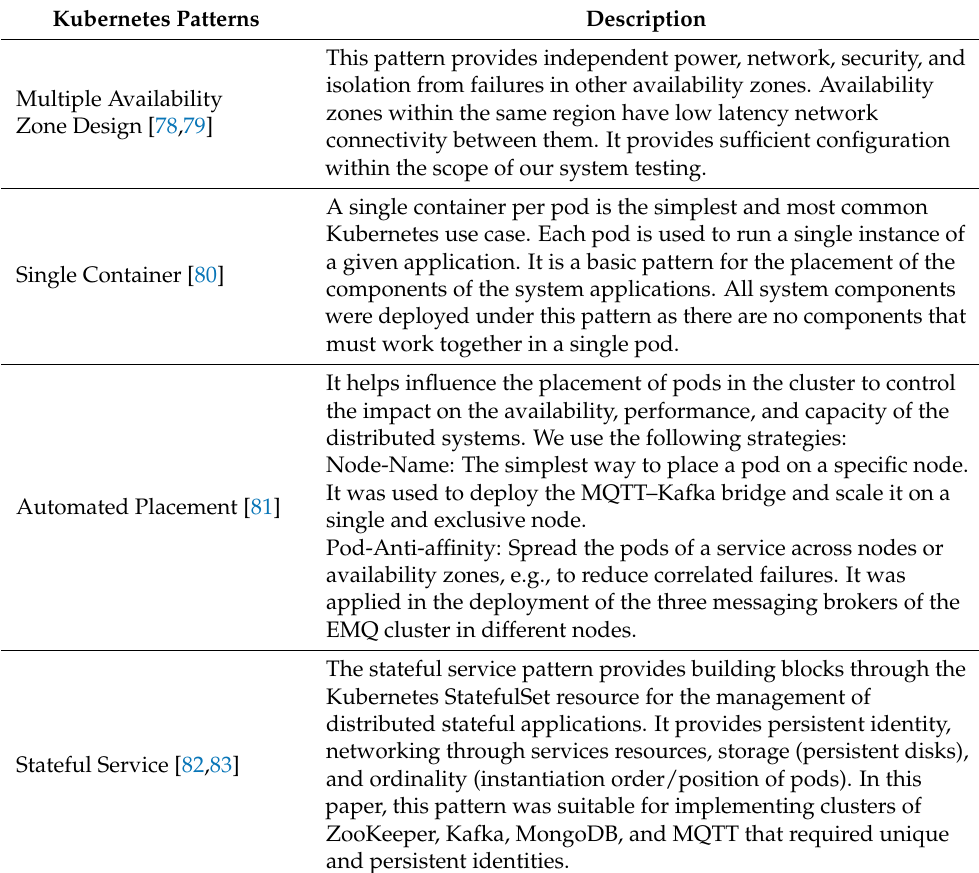
Table A5. K8s patterns and their uses in our